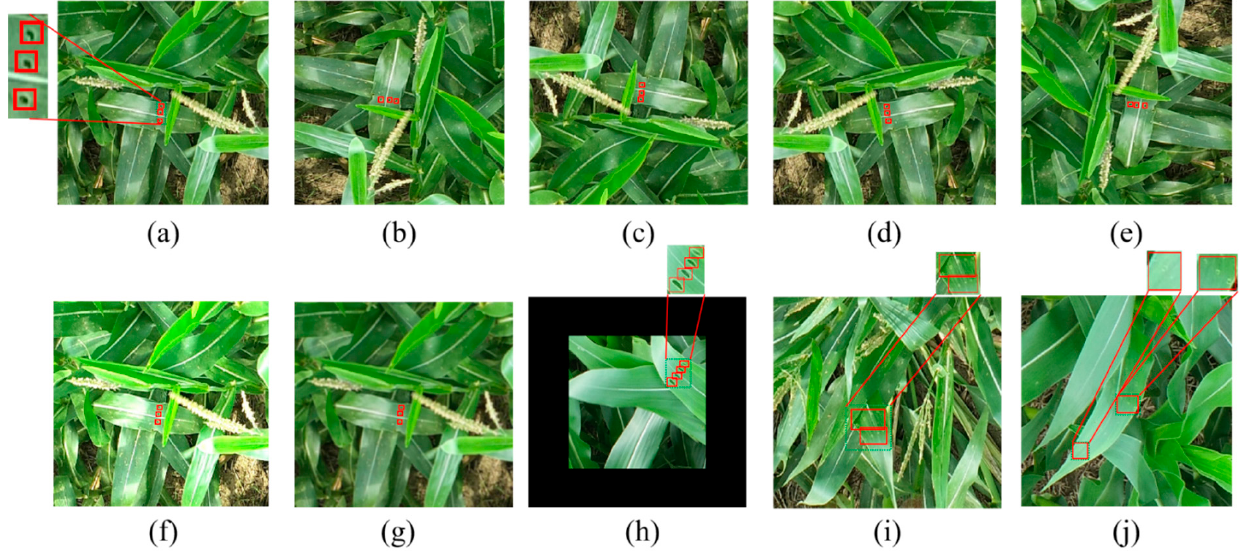
Figure 3. Image preprocessing: ( a ) original image of ( b – g ), ( b ) 90 ° clockwise rotation, ( c ) 180 ° clockwise rotation, ( d ) 270 ° clockwise rotation, ( e ) flipping, ( f ) brightness transform, ( g ) Gaussian blur processing, ( h ) padding, ( i , j ) resampling sample examples.